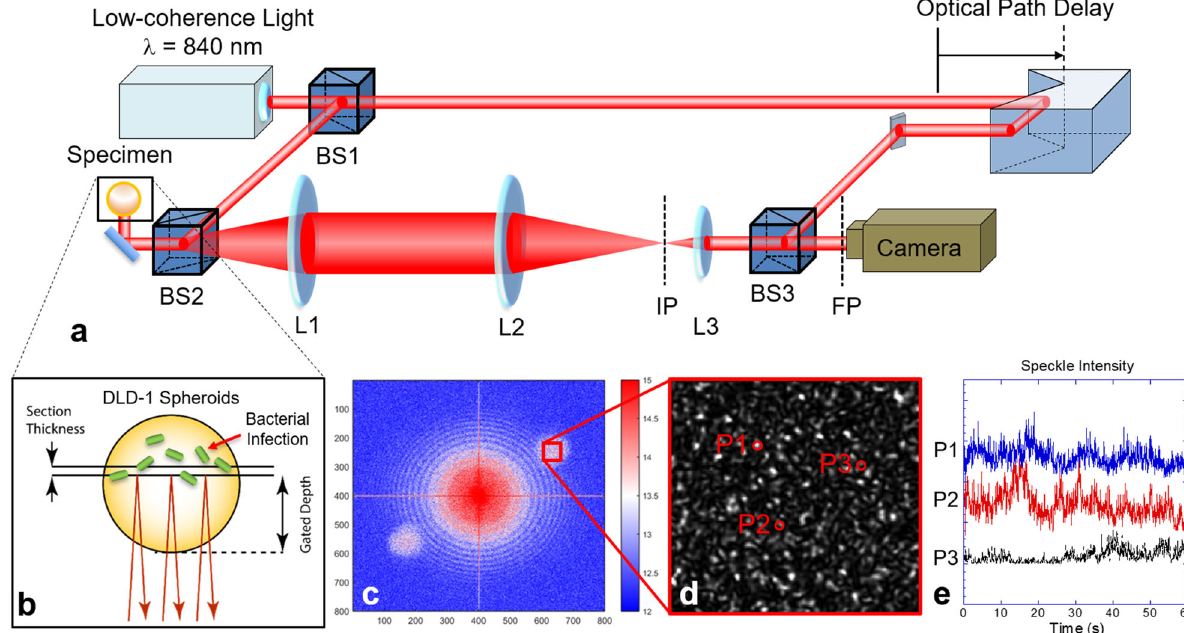
Fig. 1 Biodynamic imaging system con fi guration. a Experimental principles and setup of intracellular Doppler spectroscopic imaging. A living sample (tumor spheroid or biopsy) is optically sectioned with low-coherence backscattered infrared light on a digital camera on the Fourier plane using a Mach – Zehnder off-axis digital holographic system. The low-coherence light is split by a beam splitter (BS1) into the object and reference arms. Backscattered light is collected by the 4- f system (L1 and L2) and forms an image on the image plane (IP). The Fourier lens (L3) transfers the image onto the Fourier plane (FP). b Scattering of light from dynamic intracellular processes generates dynamic speckle that is altered when tumor spheroids are inoculated with various bacterial strains. c The Fourier-domain digital hologram is reconstructed to the image plane using a fast Fourier transform. The zero-order is in the center, and the two fi rst-order side-bands are on the diagonal. The red box shows a magni fi ed part of the image plane speckle. d A magni fi ed reconstructed speckle image. e Dynamic speckle intensity fl uctuates temporally at different locations P1, P2, and